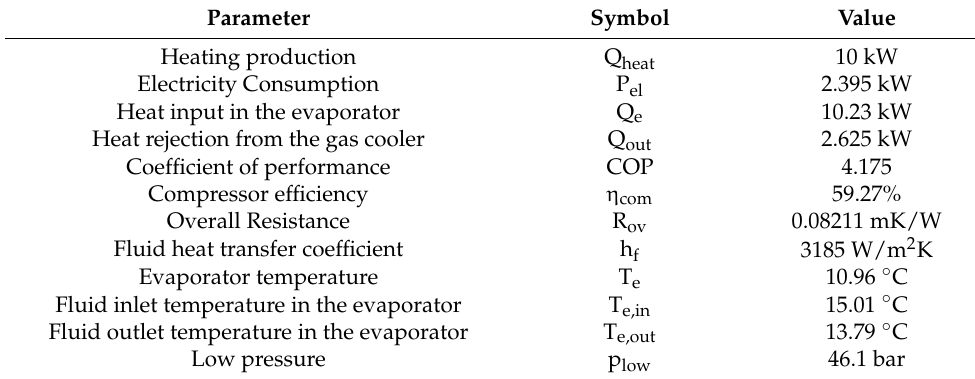
Table 3. Data for the default design scenario.